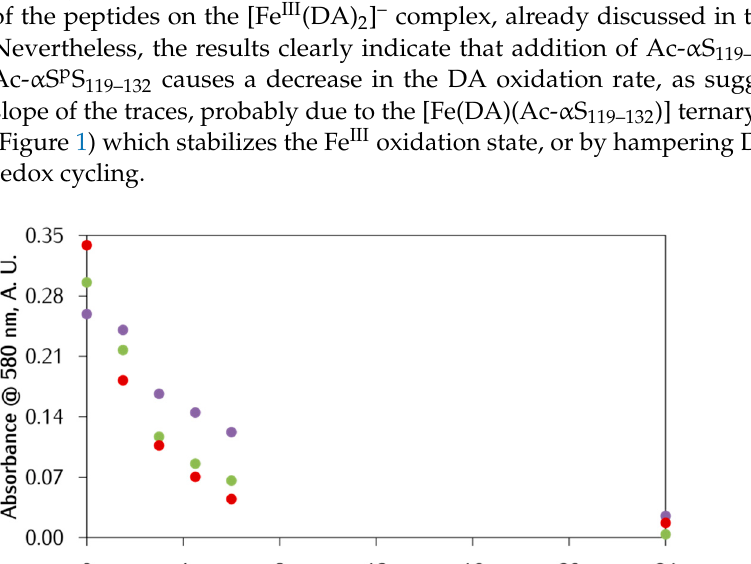
Figure 7. Kinetic traces of DA (200 µM) oxidation in Mops bu ff er pH 7.0 and 37 °C in the presence of 100 µM of Fe II (red) and 200 µM (2 equiv.) of peptide (Ac- α S 119–132 : green, Ac- α S p S 119–132 : purple).